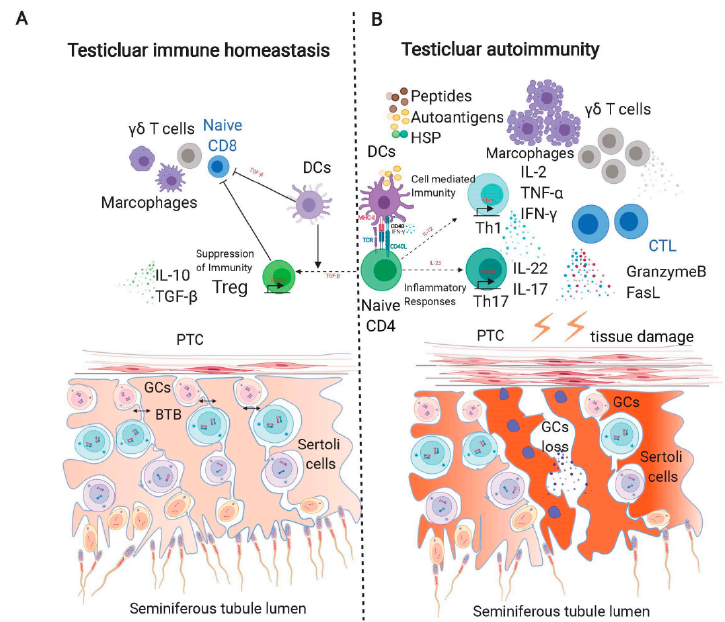
Figure 2. Hypothetical schematic model of testicular immune privilege under normal ( A ) and inflammatory ( B ) conditions. A: Under normal conditions, Th cells are tightly controlled by Tregs through multiple mechanisms. B: In the presence of chronic testicular inflammation, resulting from a temporary or silent infection, necrosis of testicular cells can lead to the release of self-antigens (e.g., HSP, ODF-2), peptides, and/or of pathogen-associated molecular patterns, i.e., LPS, which can enhance the maturation and population of antigen-presenting cells and Mø in the testes, thus further activating Th17 cells and triggering autoimmunity. CTL, cytotoxic T lymphocytes; DC, dendritic cell; GC, germ cell; HSP, heat shock protein; IDO, indoleamine 2,3-dioxygenase; T, testosterone; CCL, chemokine ligand; FasL, Fas ligand; IL, interleukin; IFN- γ , interferon; LC, Leydig cell; Mø, macrophage; ODF-2, outer dense fiber protein 2; PTC, peritubular cell; SC, Sertoli cell; TGF- β , transforming growth factor β ; TNF- α , tumor necrosis factor α ; Th, T helper cell; Treg cell, regulatory T